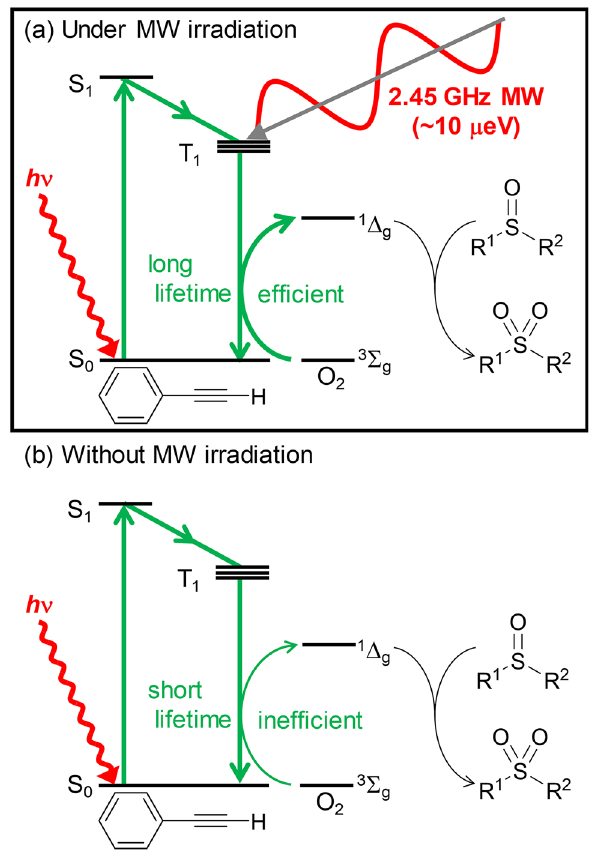
Figure 3. Proposed energy dissipation pathways. Green arrows indicate the direction of energy transfer as the oxidation progresses. Thickness of the arrows corresponds to the feasibility of the process. ( a )